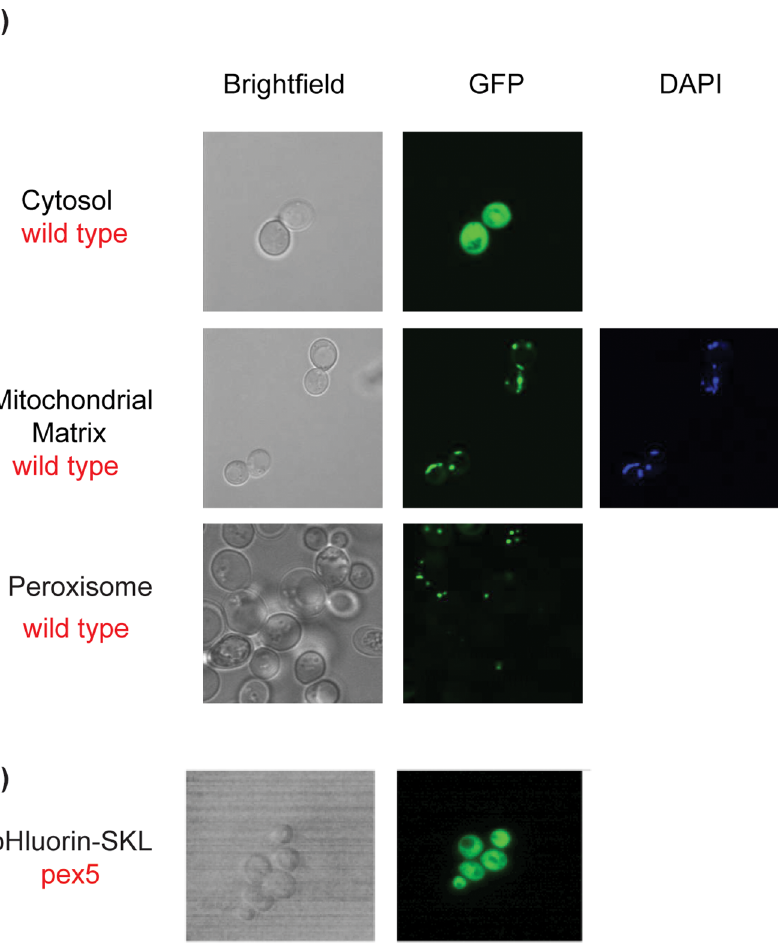
Figure 2. Confocal microscopy images of yeast cells expressing cytosolic, mitochondrial matrix or peroxisomal pHluorin. A) Wild type cells were pregrown in SC URA (48 h; 30 u C; 600 rpm), inoculated into SC URA (A 600 =0.001), grown until exponential phase and examined using an Olympus FV-1000 confocal microscope at a magnification of 100X. B) In cells where mitochondrial DNA was visualized cells were incubated with DAPI for 30 min, washed with sterile water and examined. C) pex5 cells were pregrown in SC URA (48 h; 30 u C; 600 rpm), inoculated into SC URA (A 600 =0.001), grown to exponential phase (A 600 = , 0.5) and examined using an Olympus V-1000 confocal microscope at a magnification of 100X.